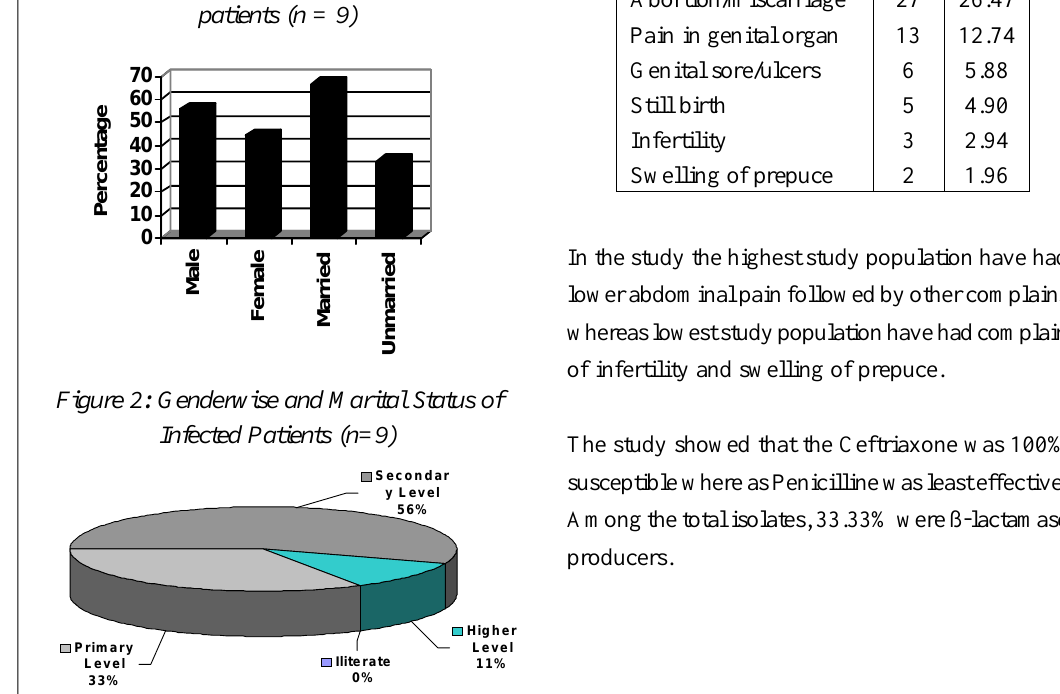
Figure 1: Age-wise distribution of infected patients (n = 9)